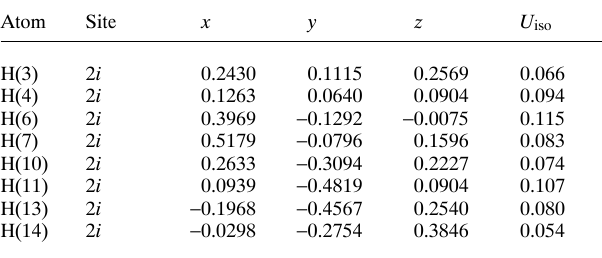
Table 2. A tomic coordin a tes a nd displ a cement p a r a meters (in Å 2 )